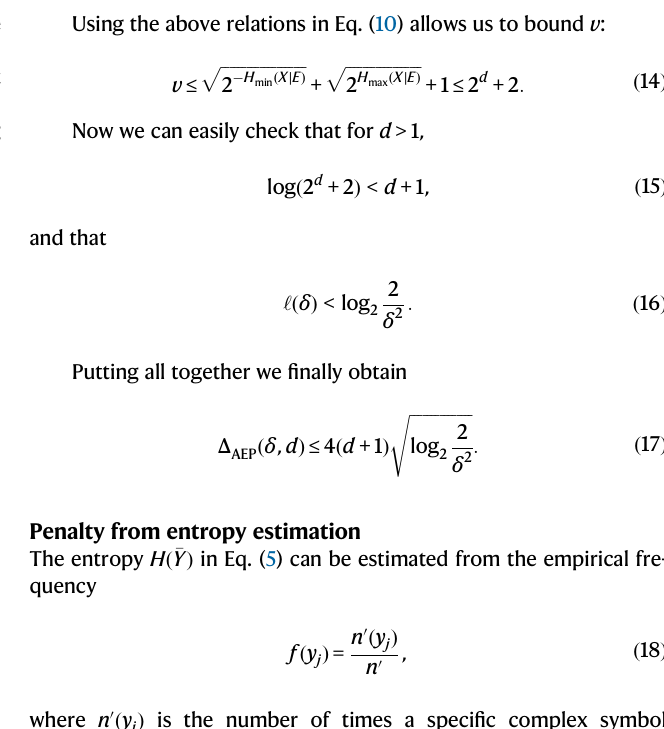
Fig. 3 | ComposableSKFresults.a Pseudo-temporalevolutionof the composable SKF with thetime parameter calculatedasthe ratioof the cumulative number N of complex symbols available for the classical steps of the protocol and the rate B =100MHzat which these symbols are modulated. b Variationof untrustednoise ξ u measured in the experiment (lower point) and its worst-case estimator (upper point), and the noise threshold to beat to get a positive composable SKF. The